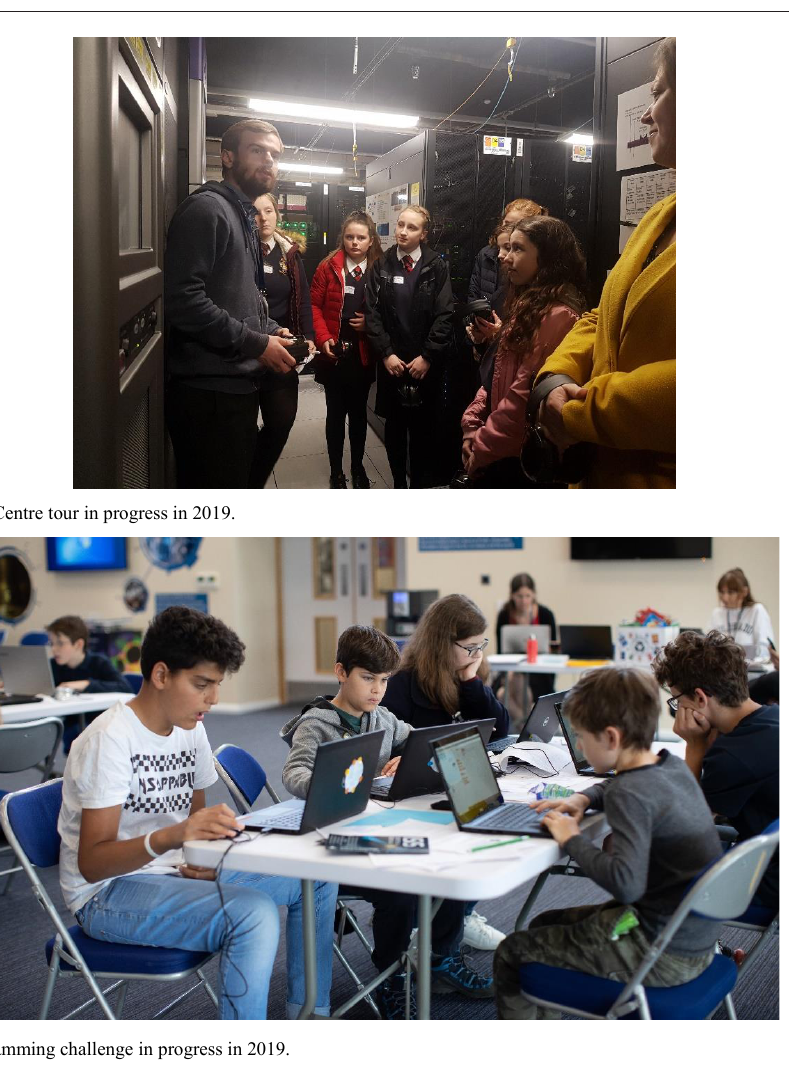
Fig. 2. A programming challenge in progress in